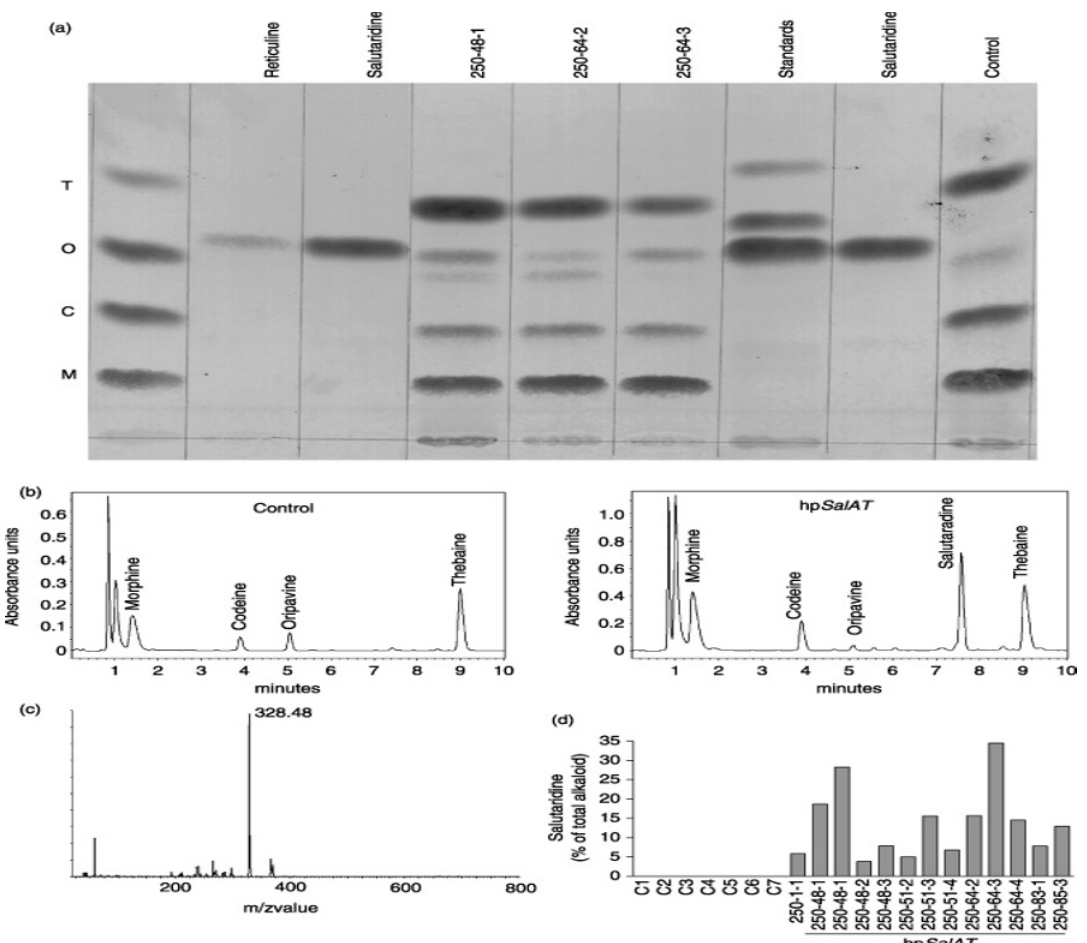
Figure 2. Thin layer chromatography (TLC), high-performance liquid chromatography (HPLC) and liquid chromatography/mass spectrometry (LC/MS) analyses of latex: (a) TLC of three families indicates the presence of the novel salutardine band not seen in the control. The track labeled standards includes reticuline, codamine and laudanine in order of increasing distance from the origin; (b) HPLC confirmed the novel accumulating alkaloid as salutaridine, the salutaridine peak is clearly present at just under 7.6 min retention time, and is absent in the control sample